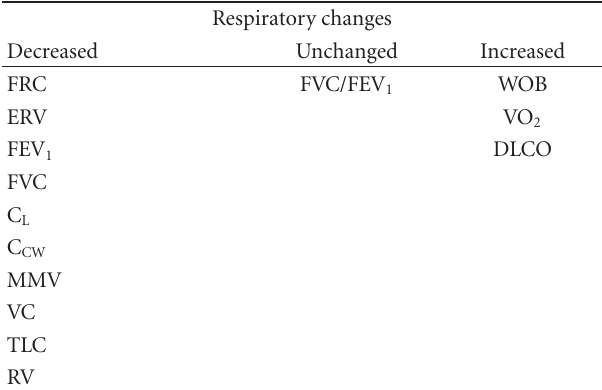
Table 1: Changes in static and dynamic lung volumes in obese patients [4, 5, 8,